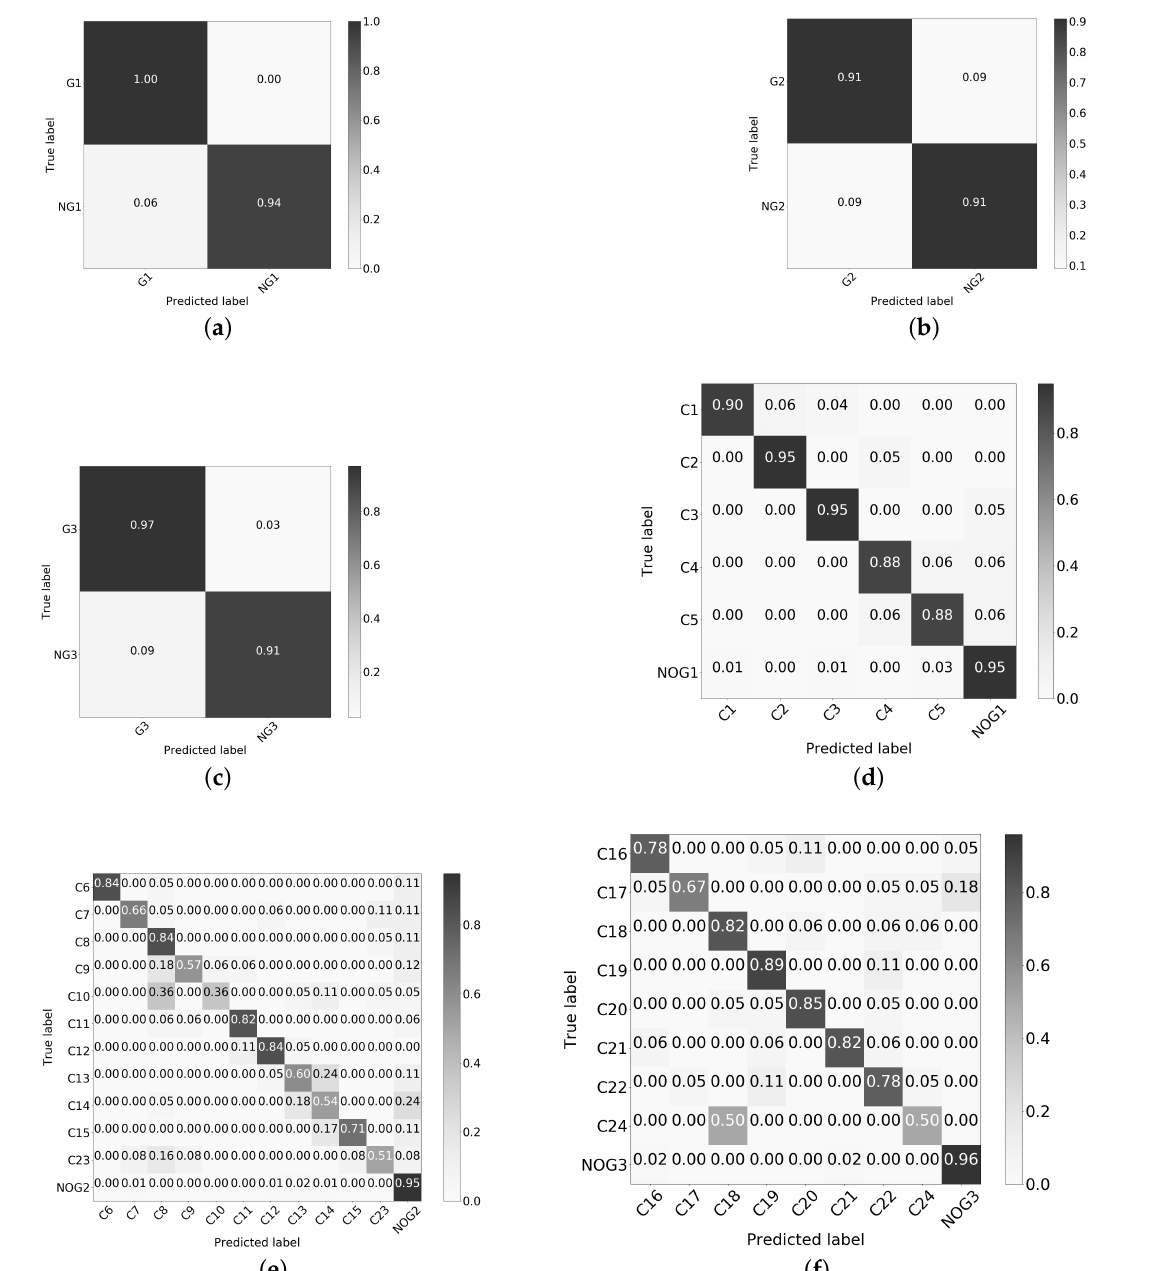
Figure 16. Phase 1 and 2 confusion matrices for the 3 wide classes classification. ( a ) Phase 1 confussion matrix for the Group 1 versus all classifier. ( b ) Phase 1 confussion matrix for the Group 2 versus all classifier. ( c ) Phase 1 confussion matrix for the Group 3 versus all classifier. ( d ) Phase 2 confussion matrix for group 1. ( e ) Phase 2 confussion matrix for group 2. ( f ) Phase 2 confussion matrix for group